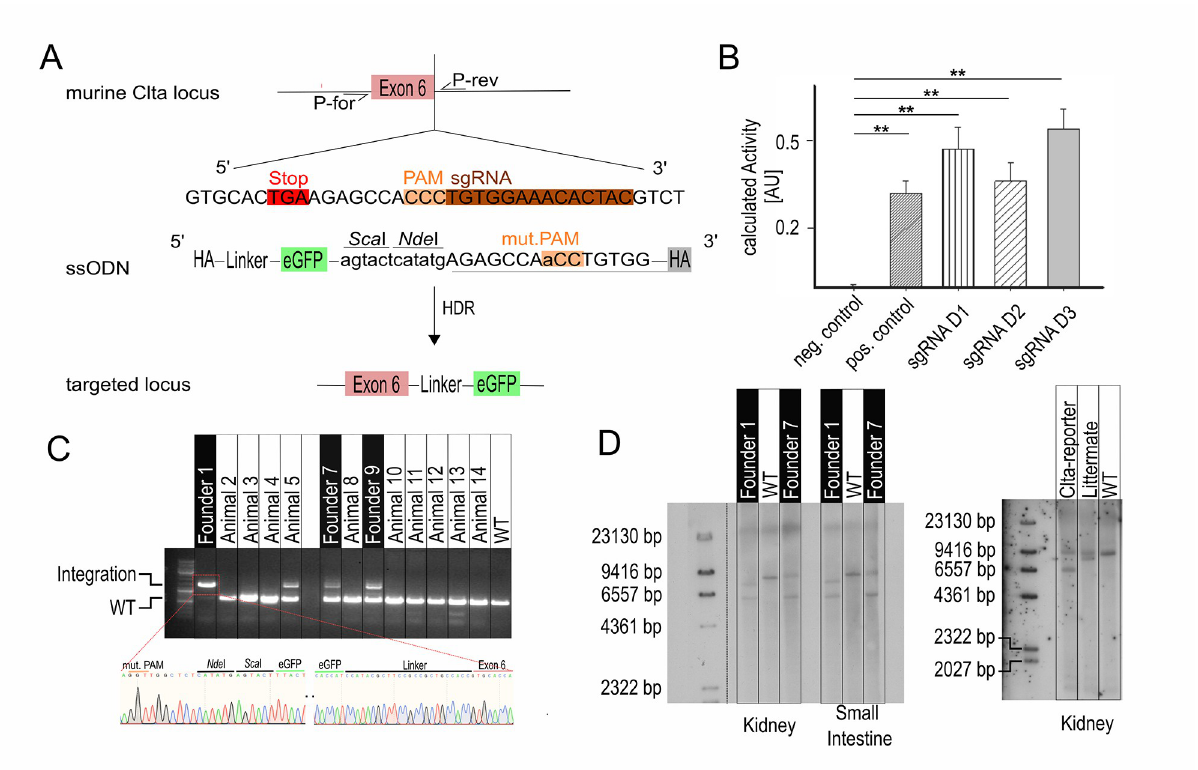
Fig 1. Endogenous tagging of Clathrin light chain a. ( A ) Targeting strategy for C-terminally endogenous tagging of Clta with eGFP using CRISPR/ Cas9. The eGFP is fused in-frame to Clta separated by a flexible linker. Additional restriction recognition sites were introduced for screening. The original PAM was mutated to prevent re-cleaving of the inserted DNA. P-for/P-rev: annealing sites of forward and reverse primers for genotyping, HA: homology arm (5’ 115 bp without stop codon, 3’ 98 bp). ( B ) Cleaving activity of the selected gRNAs using a gene complementation assay. Representative data of two individual experiments is shown. n = 3 transfections; error bars: SD; �� : p < 0.01 (students t-test). ( C ) Genotyping and sequencing of 14 live-born animals after pro-nuclear injection of crRNA-tracrRNA complex, Cas9 mRNA and ssDNA repair template. Fragment size WT: 591 bp and Clta-reporter: 1349 bp. Forward primer binding site on deleted allele of founder 1 missing, therefore no amplification. ( D ) Southern Blot Analysis of founder 1, founder 7 and WT in kidney and small intestine. Founder 1 shows, in addition to the integration band (expected at 6130 bp), a band at ~7500 bp, which is indicative for a deletion. Founder 7 shows a band migrating at the WT size (expected at 8444 bp) and one smaller band (about 6130 bp) indicative for the integration ( left ). Offsprings of F1-generation of founder 1 showed animals harboring the WT-Clta allele and an integration allele (Clta-reporter) and animals harboring the WT allele and the deletion allele (littermate) ( right ).